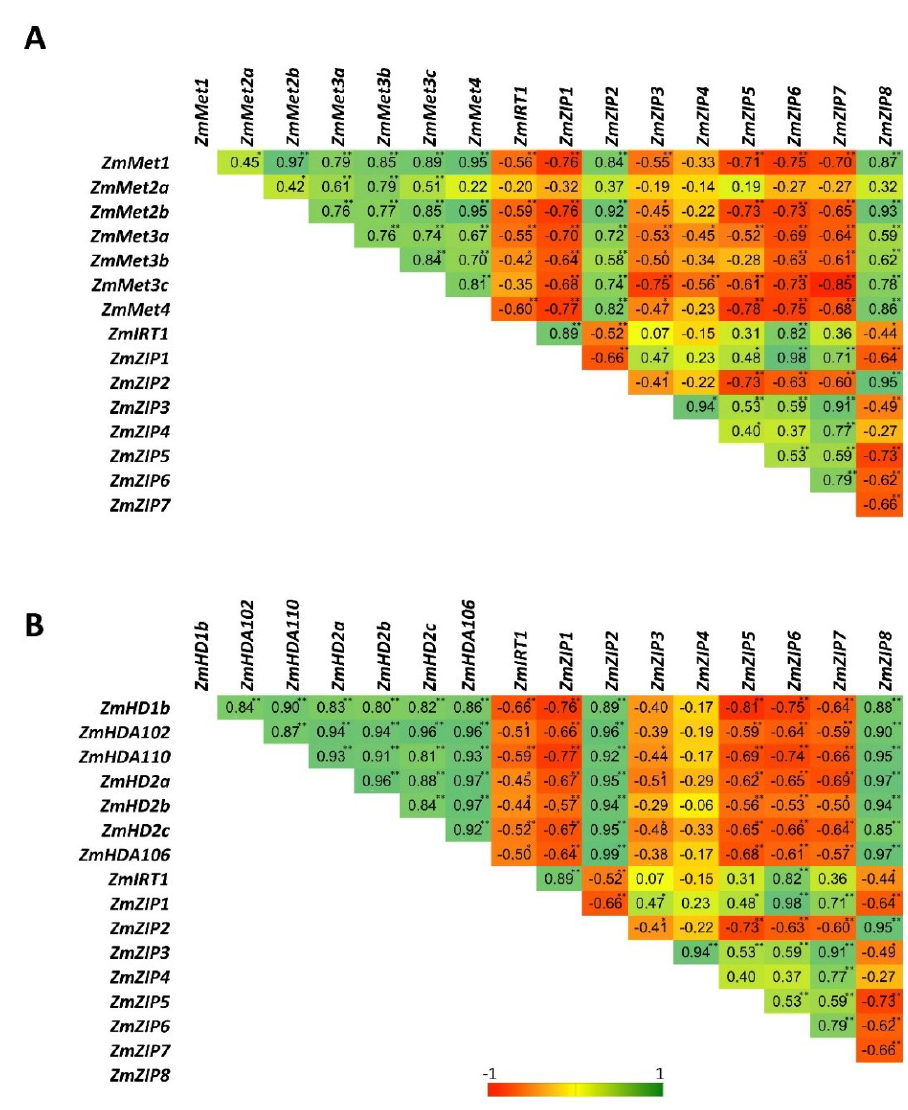
Figure 7. Pearson correlation between the expression of ZIP transporters and the expression of DNA methyltransferases ( A ) and HDACs ( B ). Red color represents the negative correlation (−1), green color represents the positive correlation (+1), and yellow represents the absence of correlation (0). * significant correlation at p ≤ 0.05, ** significant correlation at p ≤ 0.01.